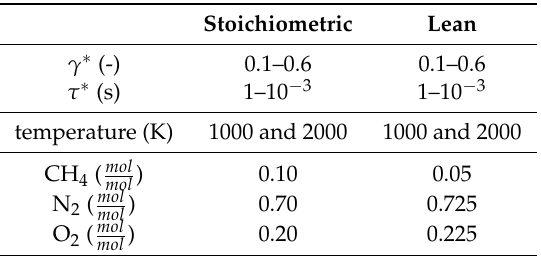
Table 1. Initial values for the simple perfectly stirred reactor (PSR) versus plug flow reactor (PFR) fine structure treatment main species test case.